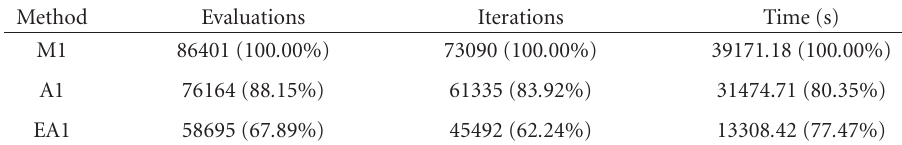
Table 4 . 1 . Overall results (876 problems).